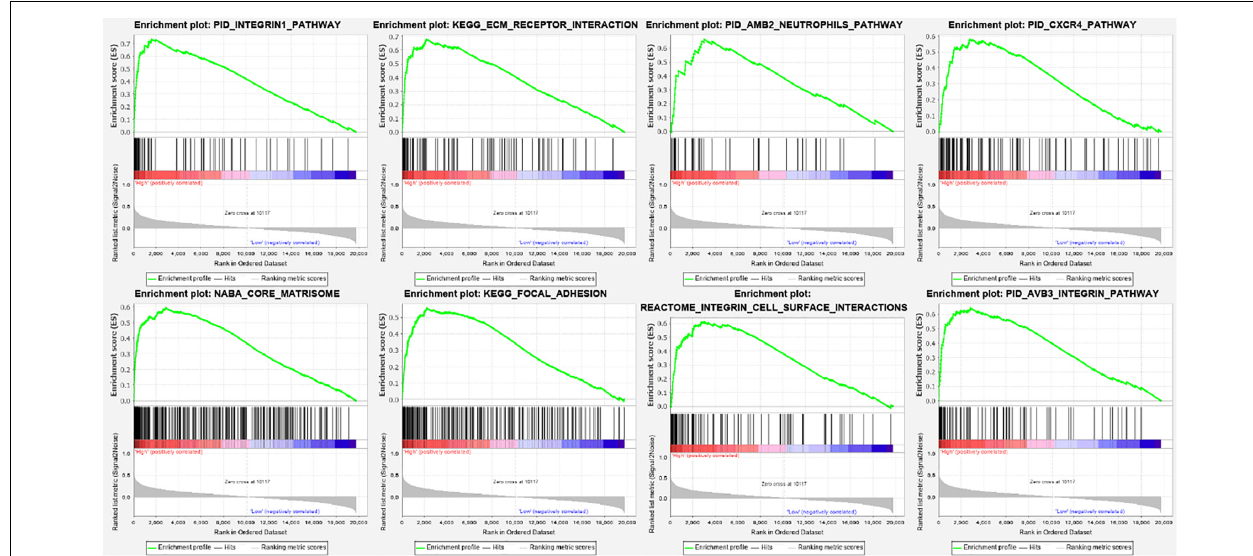
FIGURE 5 | Enrichment plots from the gene set enrichment analysis (GSEA).